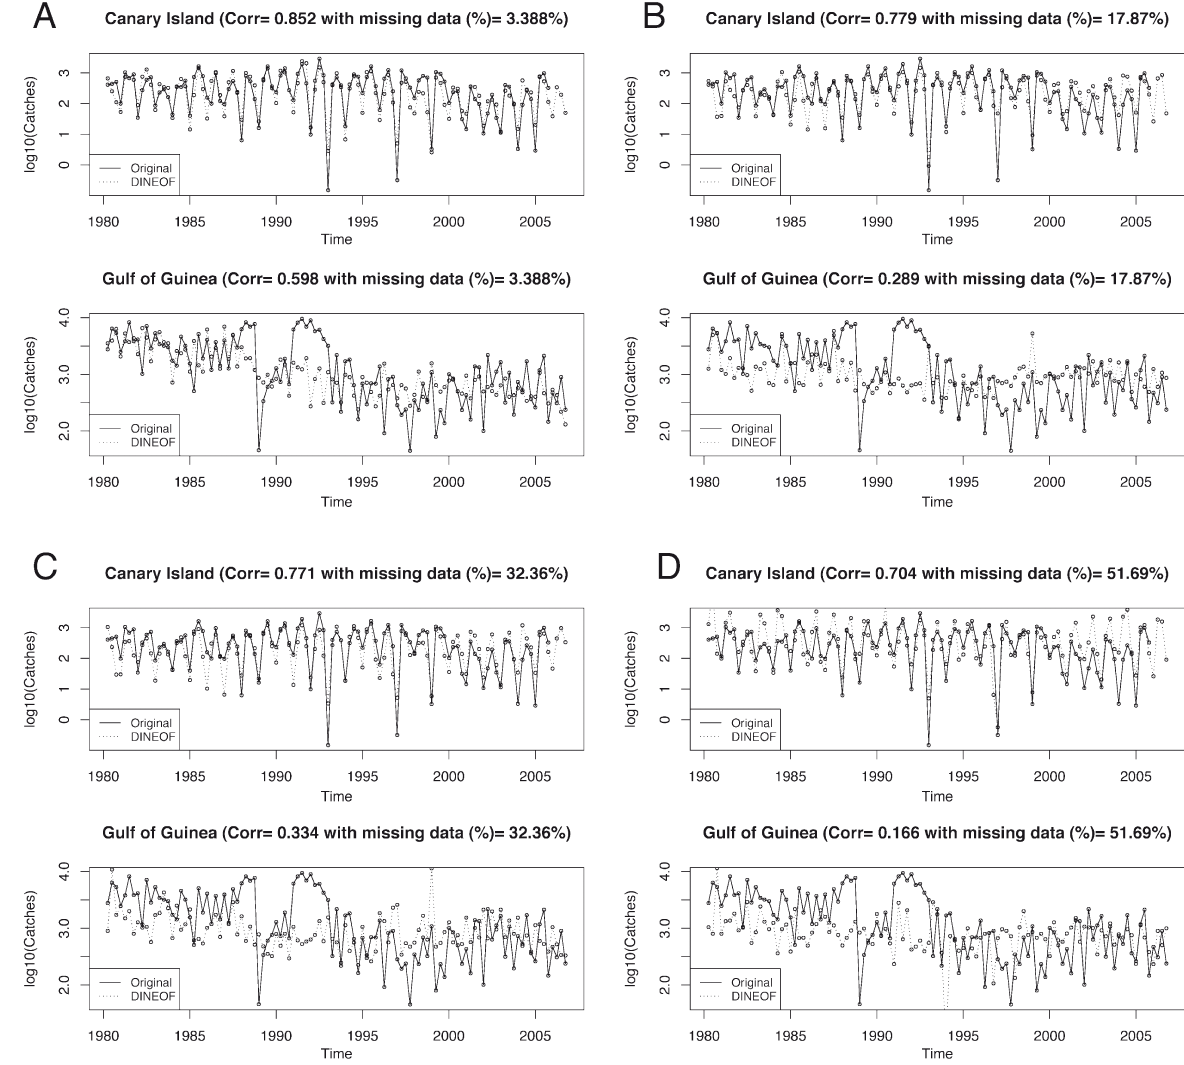
Fig . 9. – Two examples of reconstructed catches in the Canary Islands (top) and the Gulf of Guinea (bottom): A, 3.39% of missing data; B, 17.87% of missing data; C, 32.36% of missing data; and D, 51.69% of missing